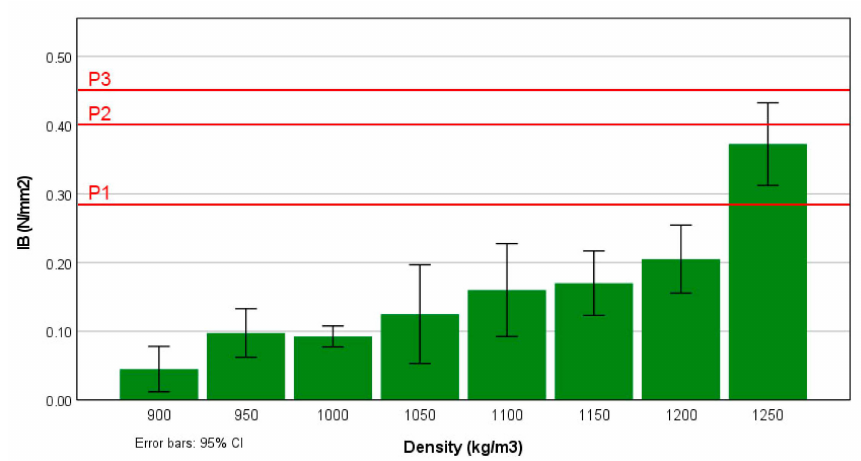
Figure 6. Internal bonding strength (IB) results of the experimental panels and the minimum require- ment of the European standards [33].